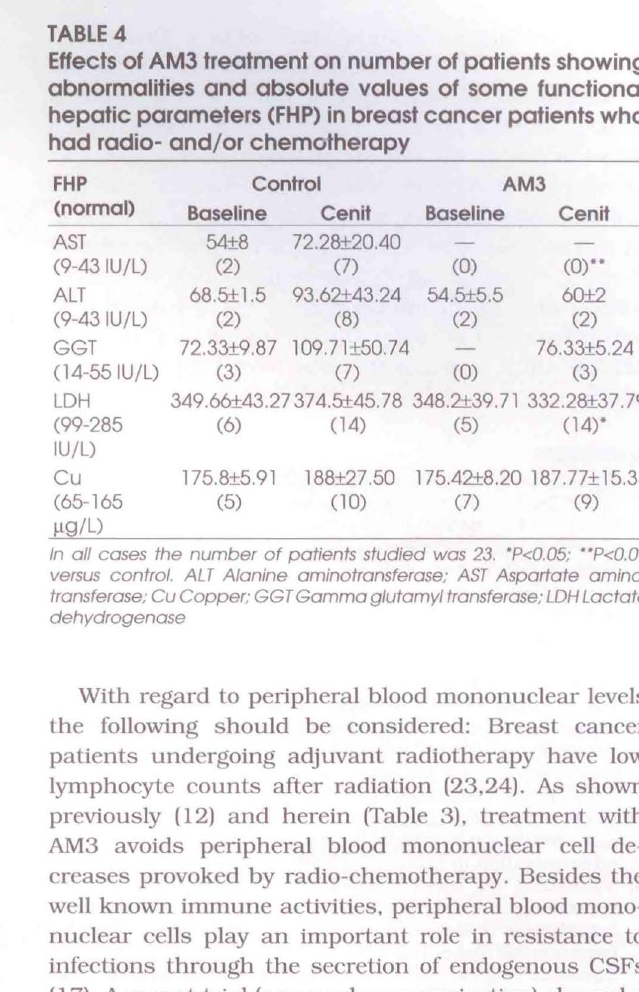
Effects of AM3 treatment on number of patients showing abnormalities and absolute values of some functional hepatic parameters (FHP) in breast cancer patients who had radio- and/or